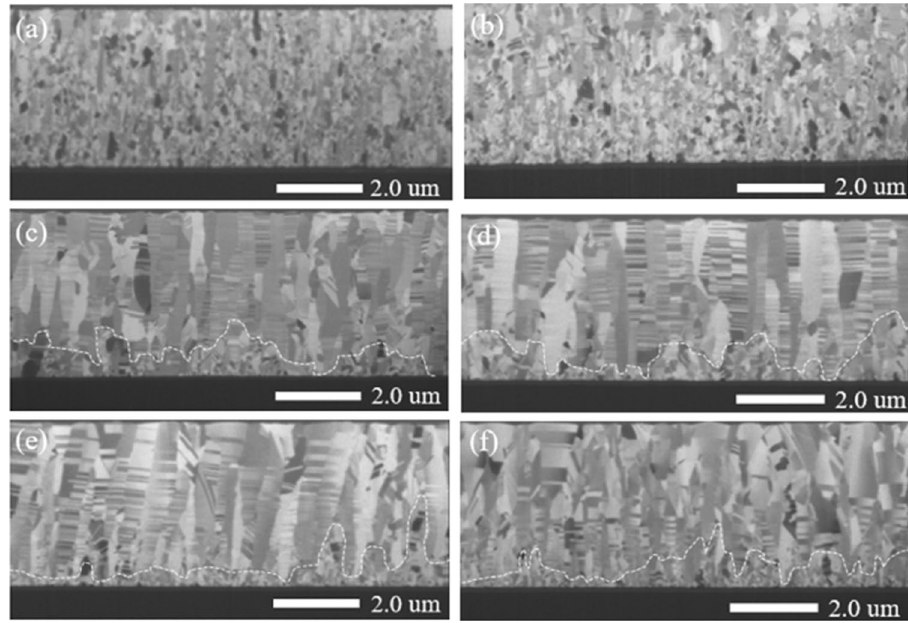
Figure 1. The FIB cross-sectional metallographs of the sputtered Cu films deposited with substrate biases of ( a ) 0 V, ( b ) − 50 V, ( c ) − 100 V, ( d ) − 150 V, ( e ) − 200 V and ( f ) − 250